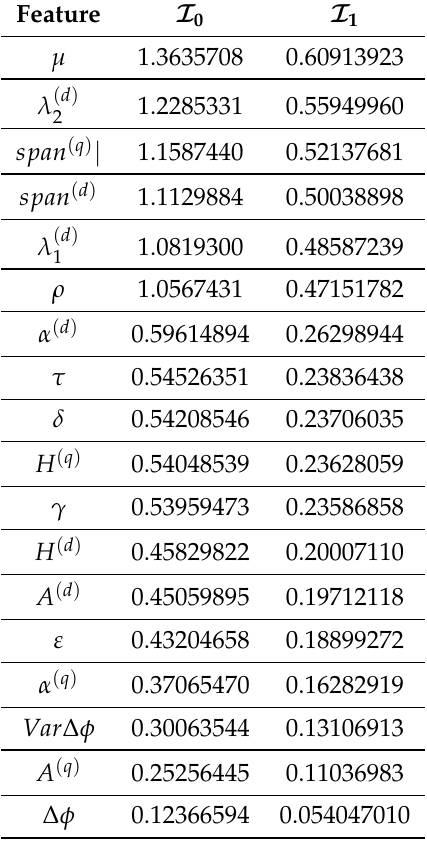
Table 2. TS-X, 2014/04/23: Relevance for distinguishing all different classes (all-class-relevance) . I 0 denotes I ( X | Class ( all )) and I 1 denotes I ( X | Class ( all )) /